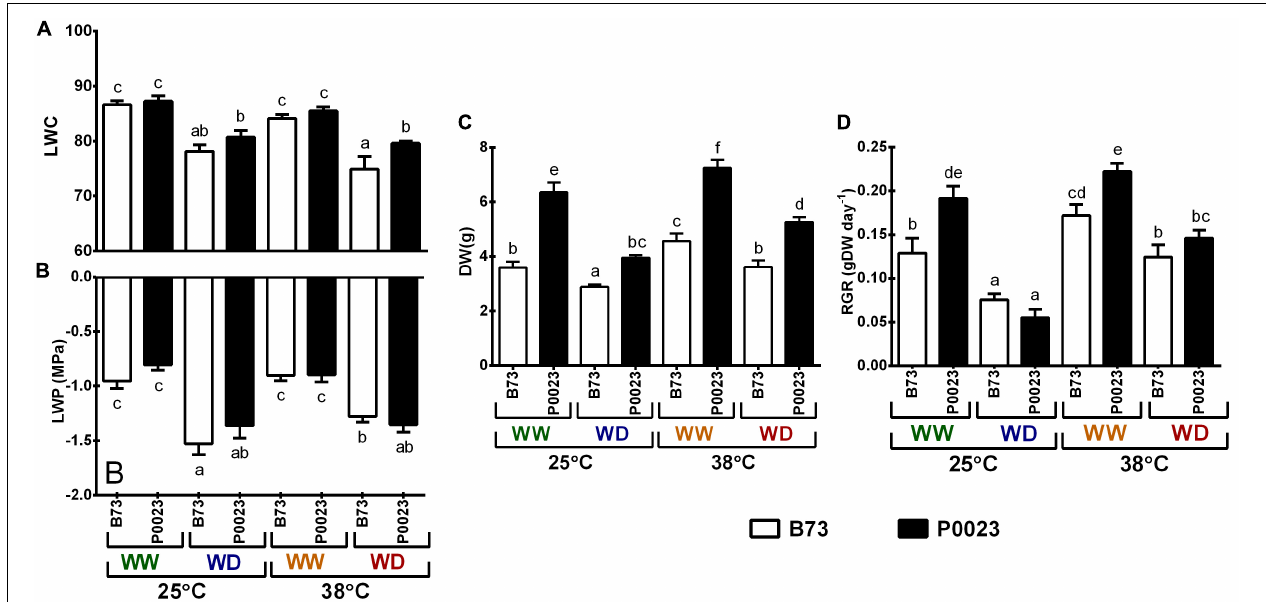
FIGURE 2 | The water status and biomass of two maize genotypes (B73, P0023) grown under WW and WD conditions and acclimatized to 25 or 38 ◦ C. (A) Water content (LWC), (B) water potential (LWP) of fully expanded leaves, and (C) above-ground biomass of 4-week-old maize plants. (D) RGR during the acclimatization period. Values are mean ± SEM ( n = 5 biological replicates). Different letters denote statistically significant differences between treatments (Duncan analysis, p < 0.05).